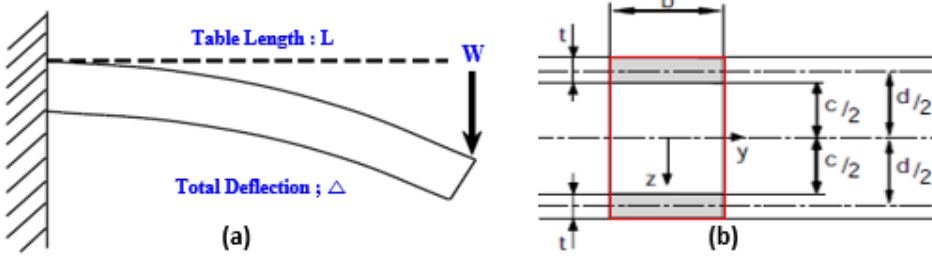
Figure 5. Structural Constraints for sandwich cradle; ( a ) deflection of sandwich cradle for external load, ( b ) cross-section and dimension notation of sandwich beam.